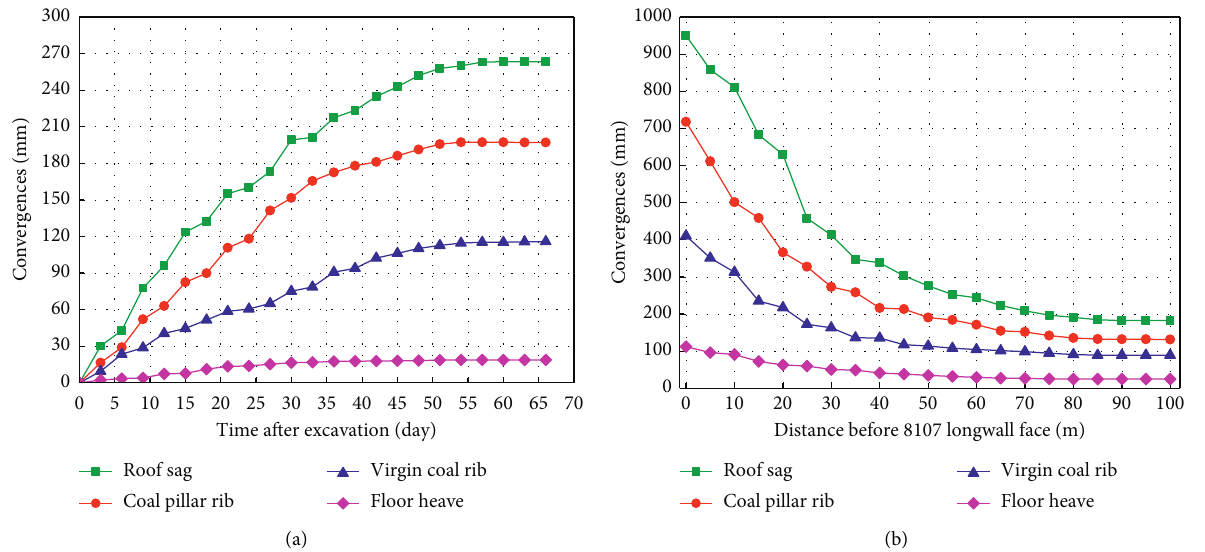
Figure 5: Measured convergences in the 8107 headgate. (a) During the 8107 headgate excavation. (b) During the 8107 panel retreat.